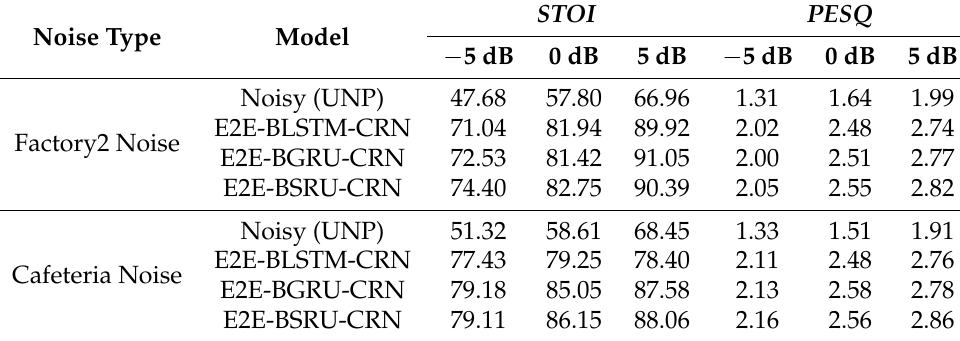
Table 5. STOI and PESQ scores in Unseen